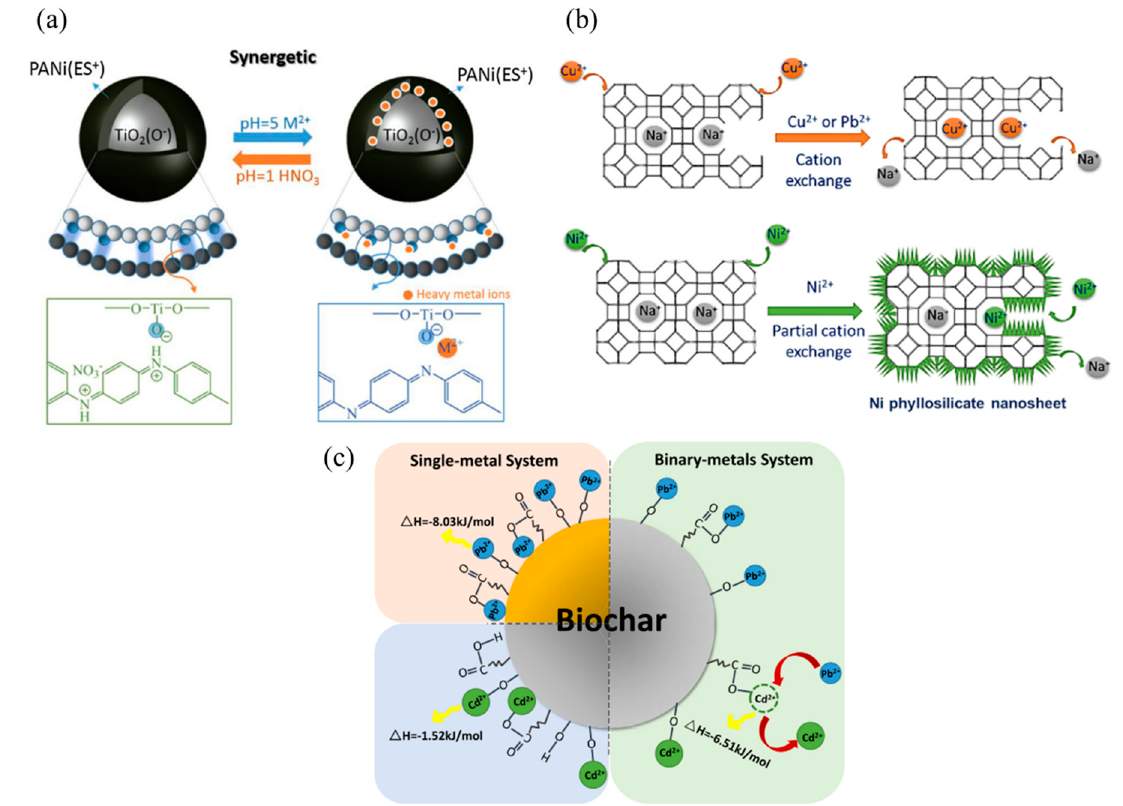
Figure 2. Schematic illustration of the adsorption of HM via the surface of ( a ) hybrid polyaniline / TiO 2 nanocomposite adsorbents. Adapted from [45], with permission from Elsevier, 2018. ( b ) cation exchange by hierarchically porous zeolite for improved adsorption of cationic HMs. Adapted from [46], with permission from Elsevier, 2019. and ( c ) selective HM ion adsorption by biochar in a single and binary metal system. Adapted from [47], with permission from Elsevier, 2019.